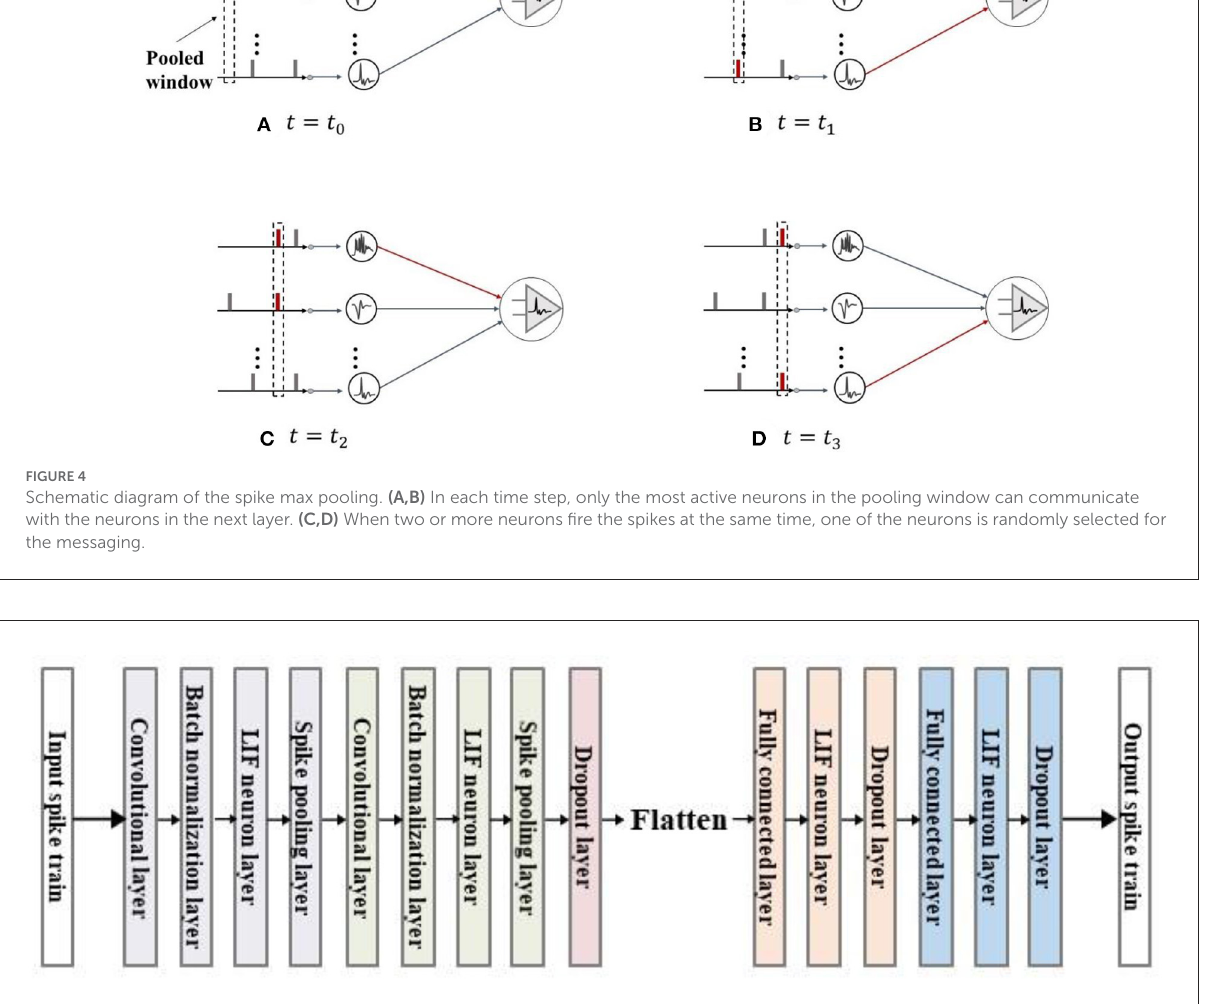
FIGURE5 Structure diagram of the backbone